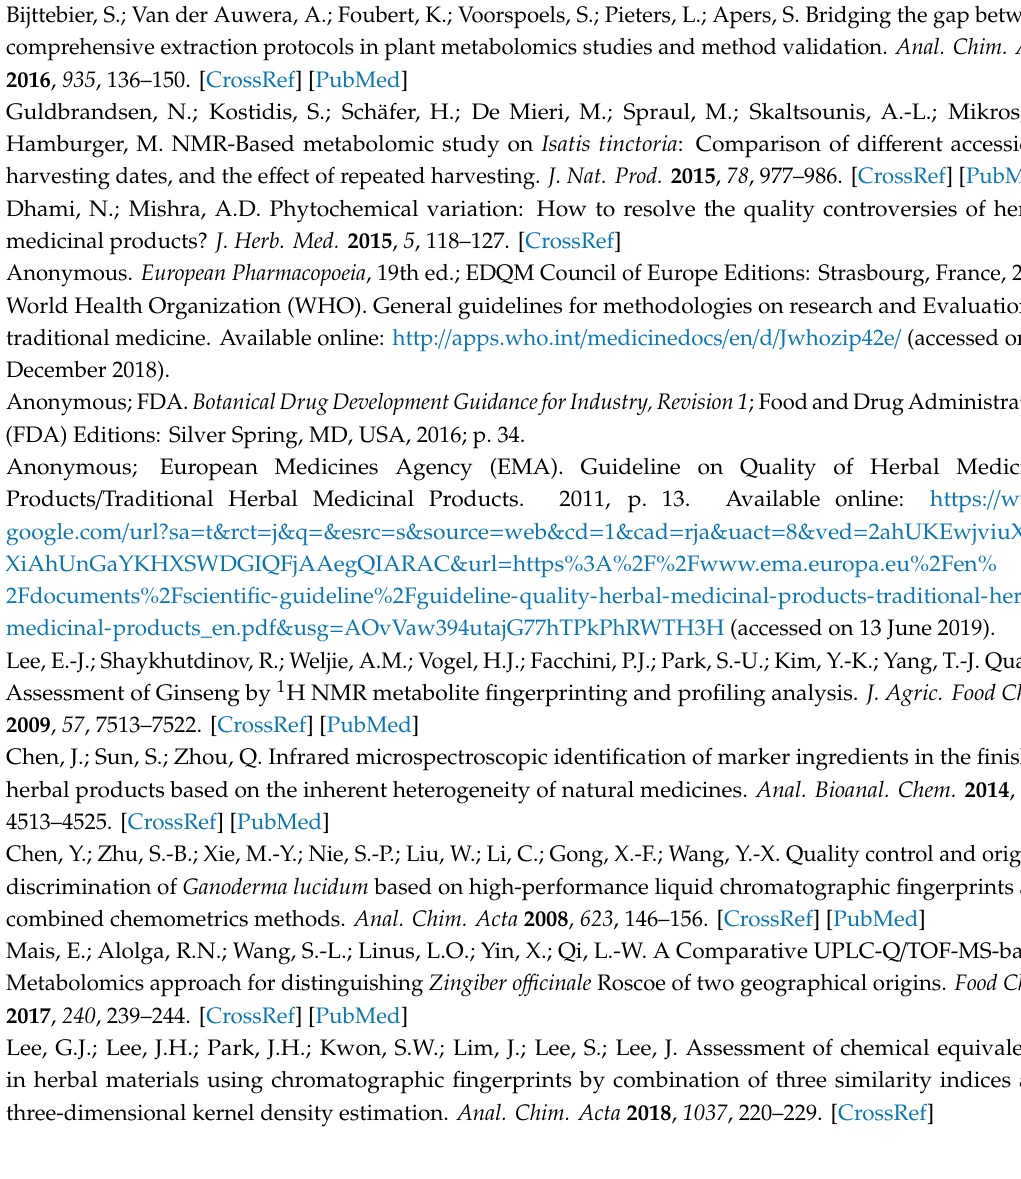
Supplementary Materials: The following are available online, Figure S1: LC-MS chromatogram (QC sample) in negative and positive ESI modes using C18 or HILIC separation columns, Table S1: Extraction Method of the Top 10 Serenoa repens Medicinal Products Sold in Europe, Table S2: Annotated LC-MS